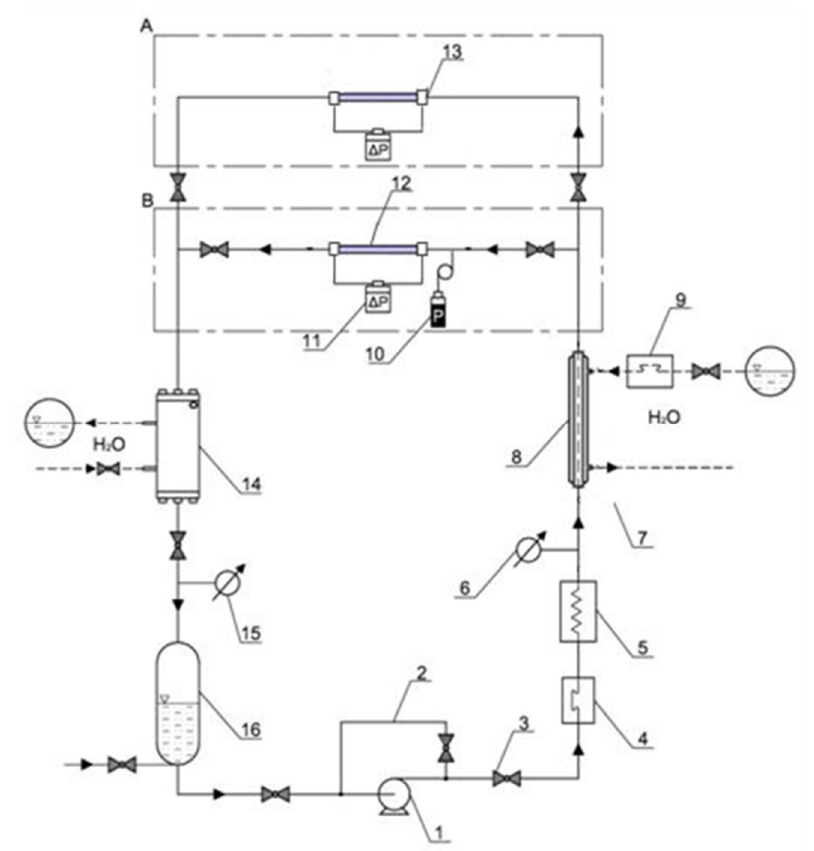
Figure 2. Schematic diagram of the test stand for thermal-flow and visualization tests of